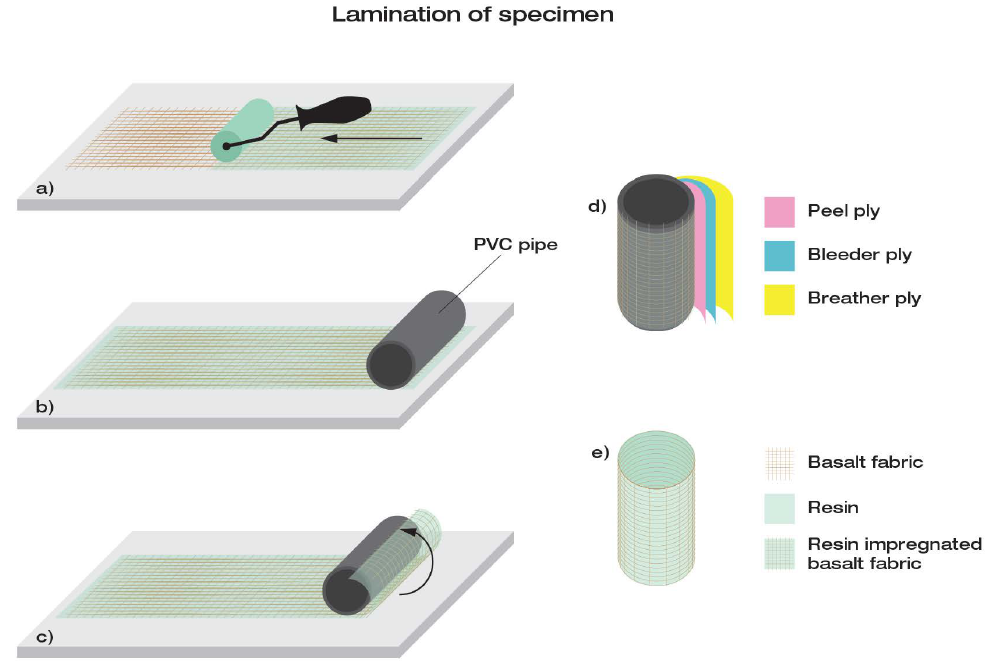
Figure 3. HLU lamination of the specimens: ( a ) Impregnation of virgin basalt fabric (brown) with epoxy resin (green); ( b ) Impregnated fabric and PVC pipe coated with wax release agent used as a mould; ( c ) Rolling of the impregnated fabric on a PVC pipe; ( e ) Stratification of plies for curing process of resin; ( d ) Cylindrical specimen in